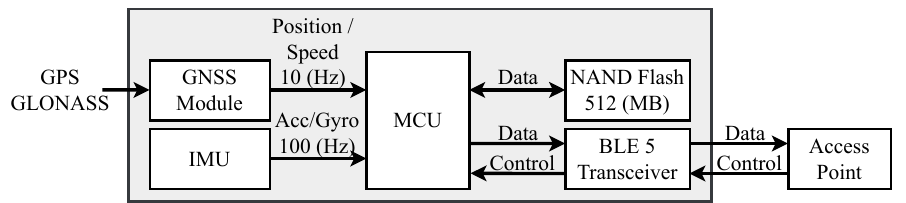
Figure 2. A block diagram of the proposed wearable EPTS